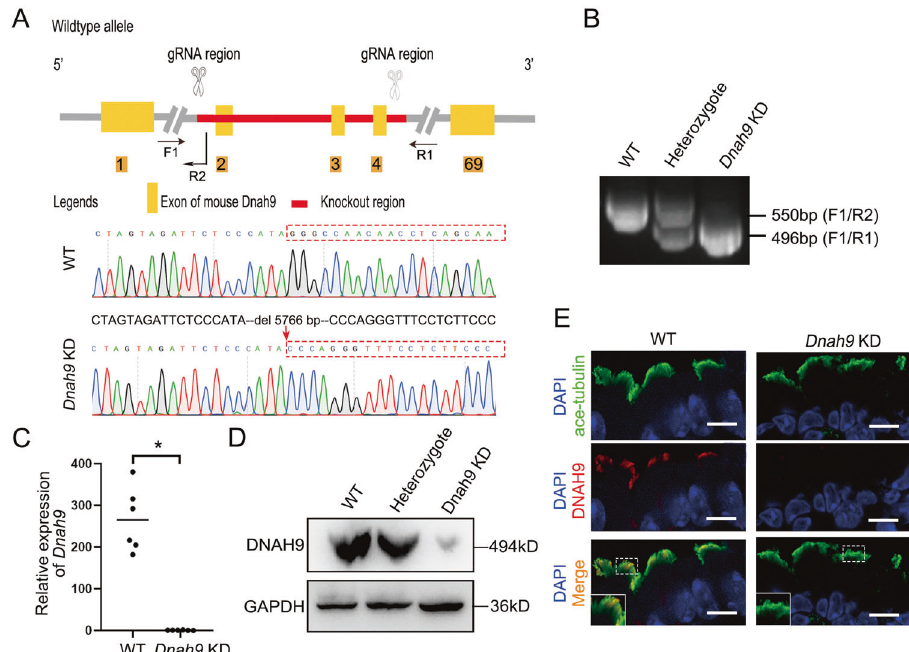
Fig. 3 Generation and veri fi cation of Dnah9 KD mice model. A The construction schematic drawing of the Dnah9 KD model. The gRNAs target in exon2-exon5 of Dnah9 to delete the gene region. The sanger sequence of WT and KD mice are shown; red dash box indicate different genome sequence which is attributed to deletion of 5766 bp. B The genotype of Dnah9 KD, heterozygote, and WT. A single 550 bp band refers to WT, combination of 550 bp and 496 bp bands refer to the heterozygote, and single 496 bp refers to Dnah9 KD. C RT-PCR of mRNA isolated from WT and Dnah9 KD mice lung showing reduced Dnah9 mRNA expression in the Dnah9 KD mice. * P < 0.05. n = 3 per group D Western blot analysis is used to detect KD ef fi ciency. E The immunostainings of tracheal tissue with anti-DNAH9 and anti-ace-tubulin depicting the absence of DNAH9 protein and the cluttered arrangement of cilia in Dnah9 KD mice. Green, ace-tubulin; red, DNAH9; bule, DAPI. Scale bar = 10